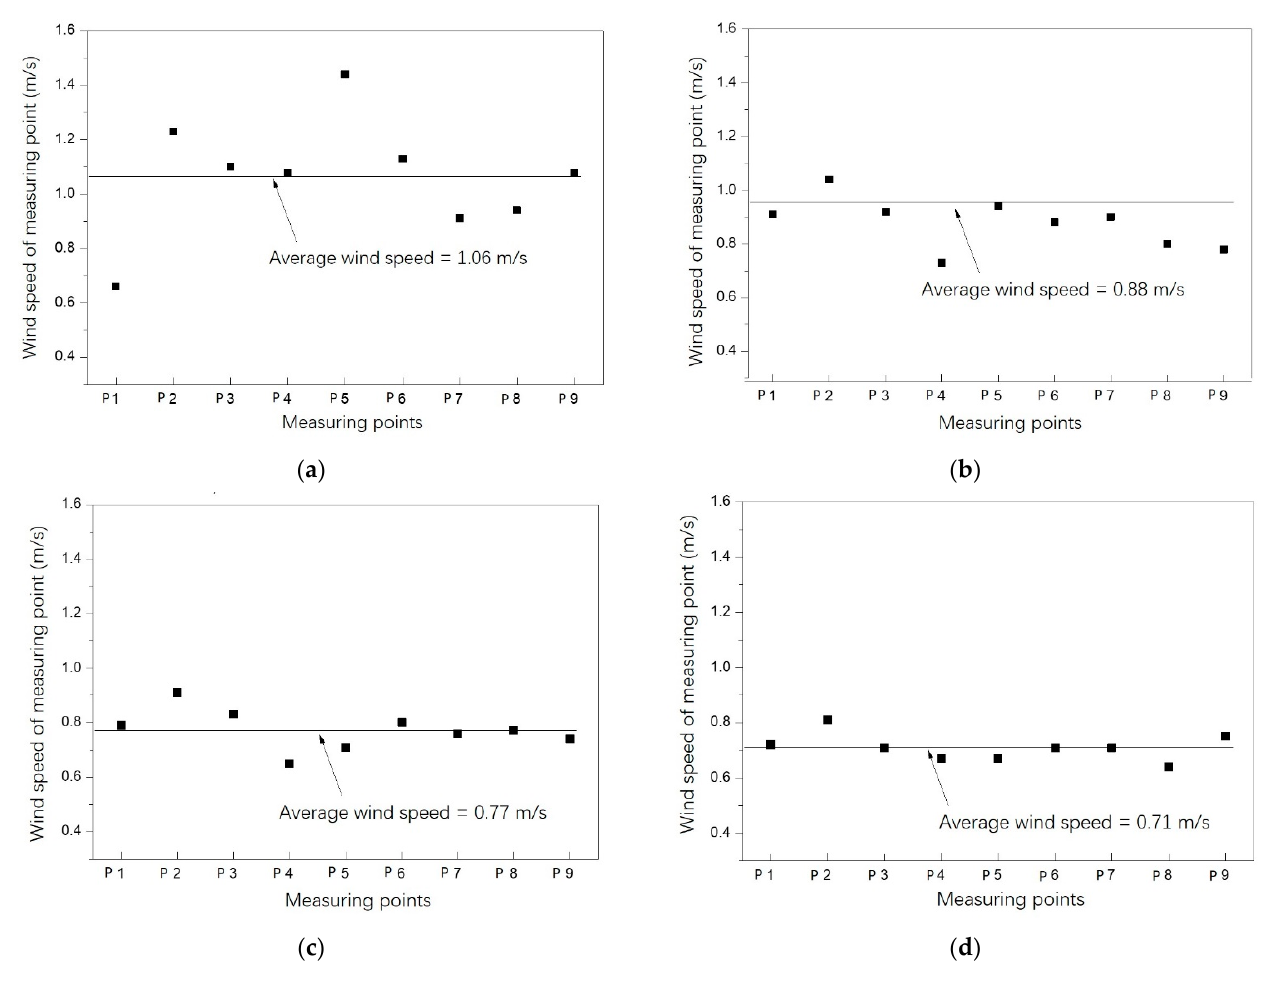
Figure 5. Wind speed of the measuring points on the different sections (case 1). ( a ) 2 m away from the air supply inlet; ( b ) 2.5 m away from the air supply inlet; ( c ) 3 m away from the air supply inlet; ( d ) 4 m away from the air supply inlet.